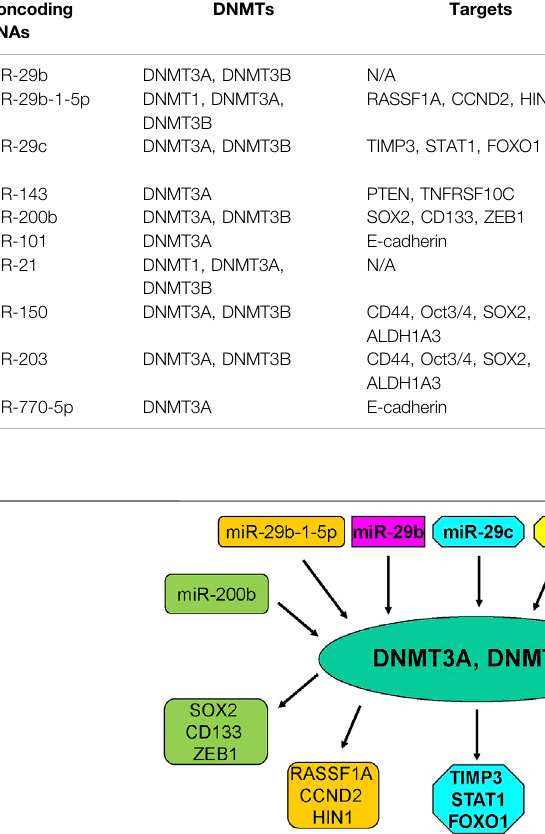
TABLE 2 | miRNAs regulate DNMTs in breast cancer. Noncoding RNAs